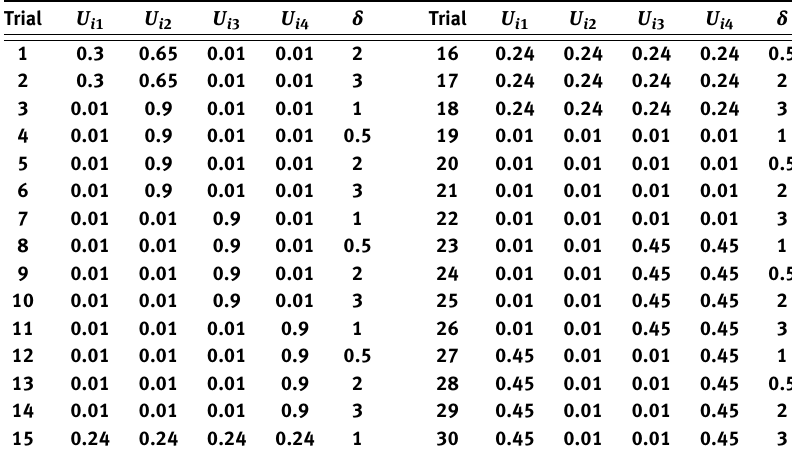
Table 3. Results from simulations exploring effect of copula parameter variation.